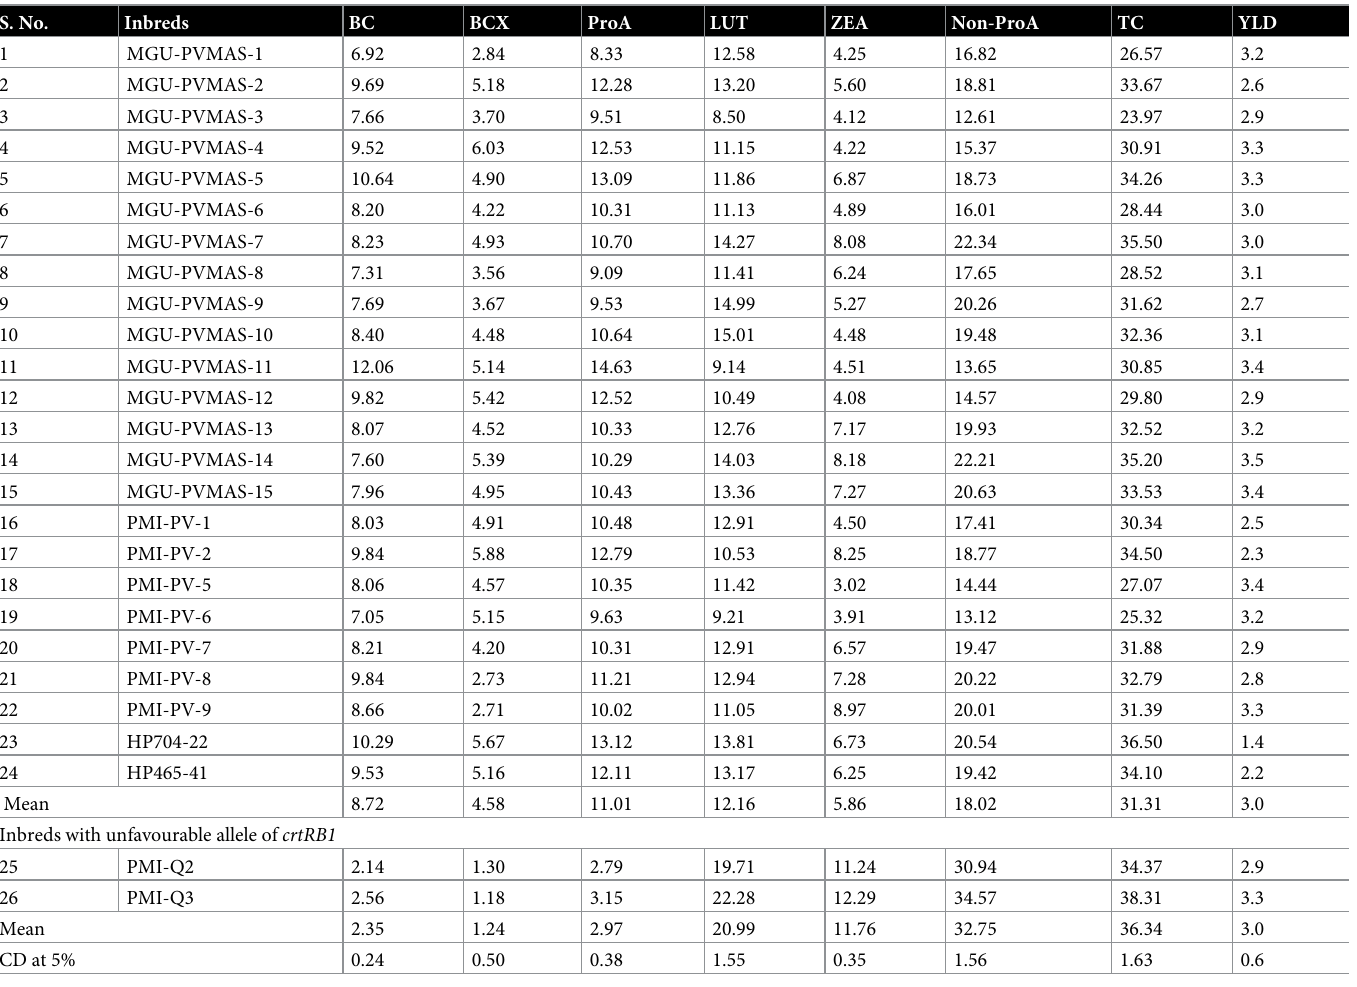
Table 4. Mean concentration ( μ g/g) of carotenoids and grain yield (tha) among